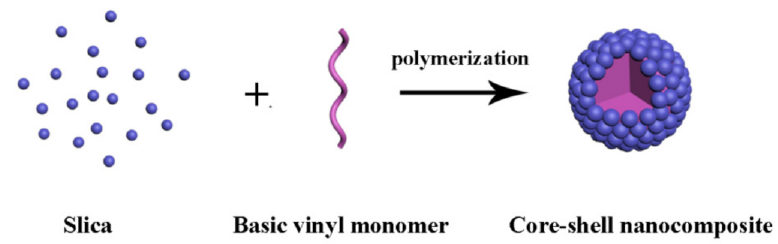
Figure 4. Schematic diagram of the acid–base